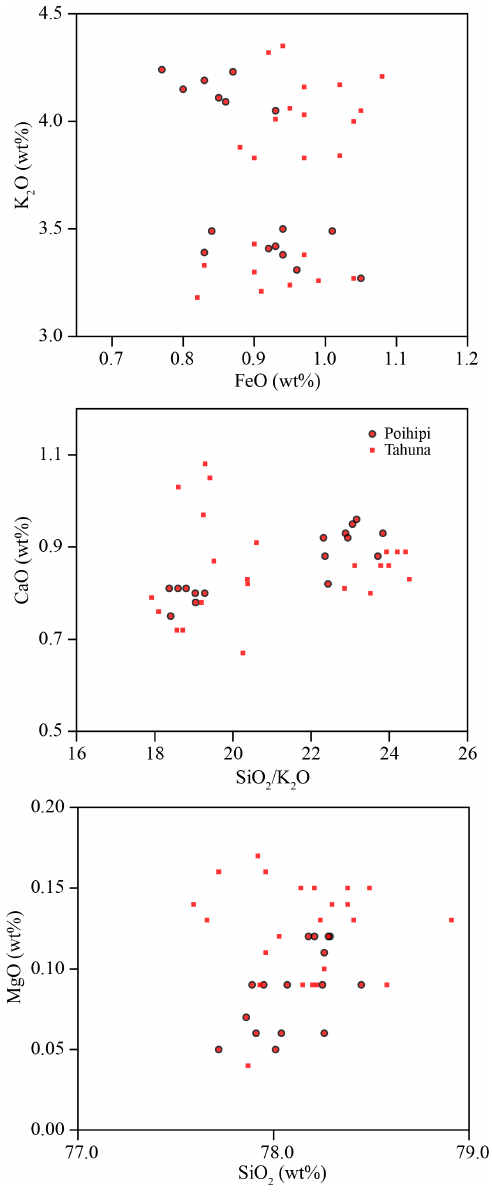
Figure 6. Selected major-element biplots of glass analyses (pre- sented on a normalised basis) of samples from Poihipi and Tahuna tephras (both TVC sourced) that exhibit a bimodal signature. This bimodality is identified as being caused by K 2 O concentration (e.g. see Lowe et al., 2008; Shane et al., 2008), and therefore plots with other elements (major or trace) do not show this bimodality. Total iron is expressed as FeO.